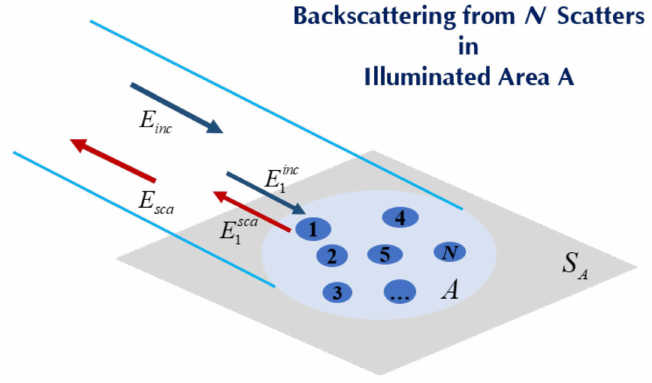
Figure 2. Illustration of backscattering from N scatters within A